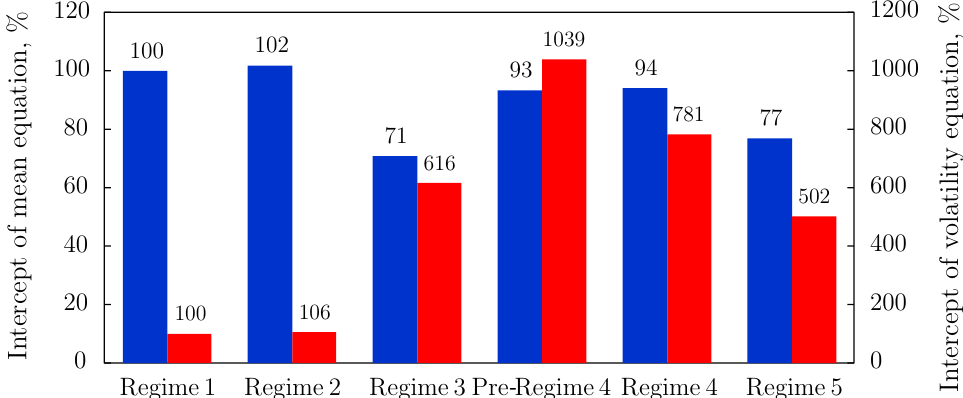
Figure 6. Price level and volatility during regulatory regime periods. Notes: Regime 1 is the reference period, 100%. Blue and red columns represent percent values of the intercept from the mean and volatility equations, respectively (based on Table